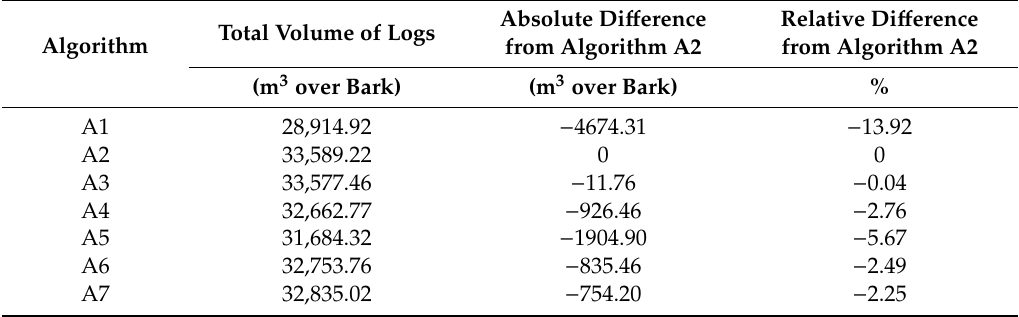
Table 3. Absolute and relative di ff erences between the log volume estimates by seven di ff erent algorithms according to StanForD Classic. Di ff erences were related to Algorithm A2.